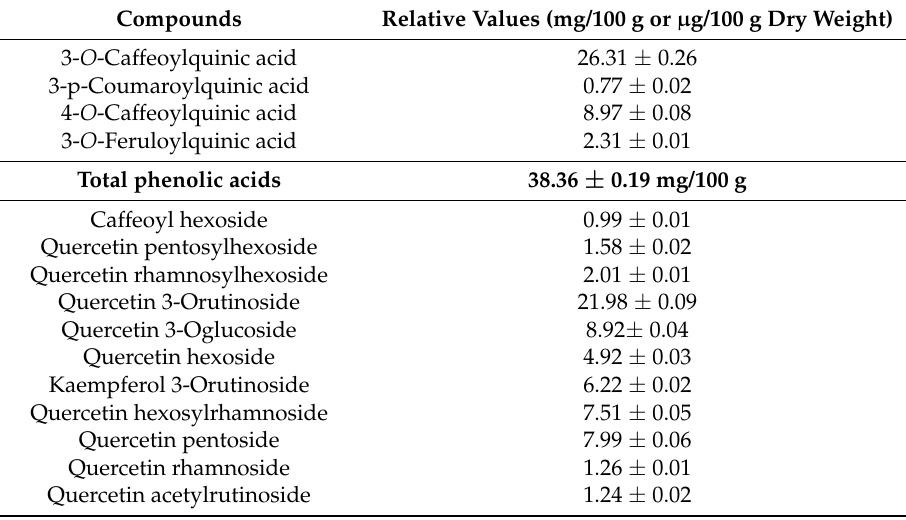
Table 1. Phenolic acids, flavones/ols and anthocyanins of fully mature blackthorn